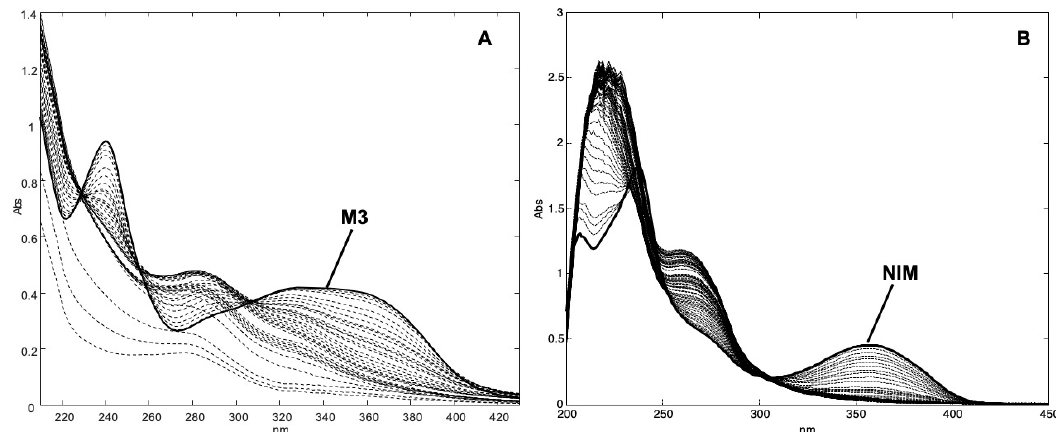
Figure 2. UV spectra recorded during the photodegradation experiments on ethanol solutions of M3 ( A ) and nimodipine (NIM) ( B ).